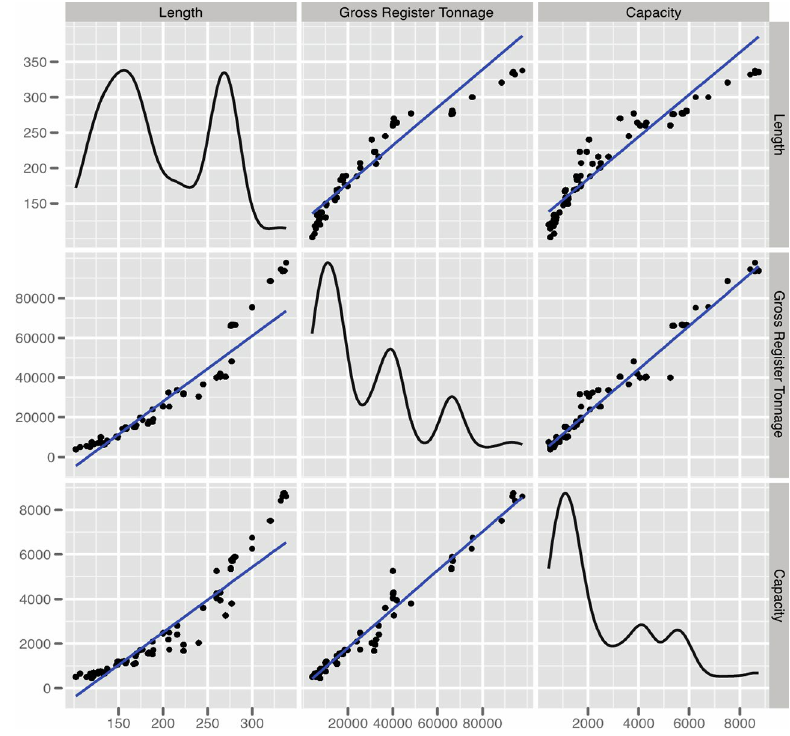
Fig. 5. Correlation matrix,